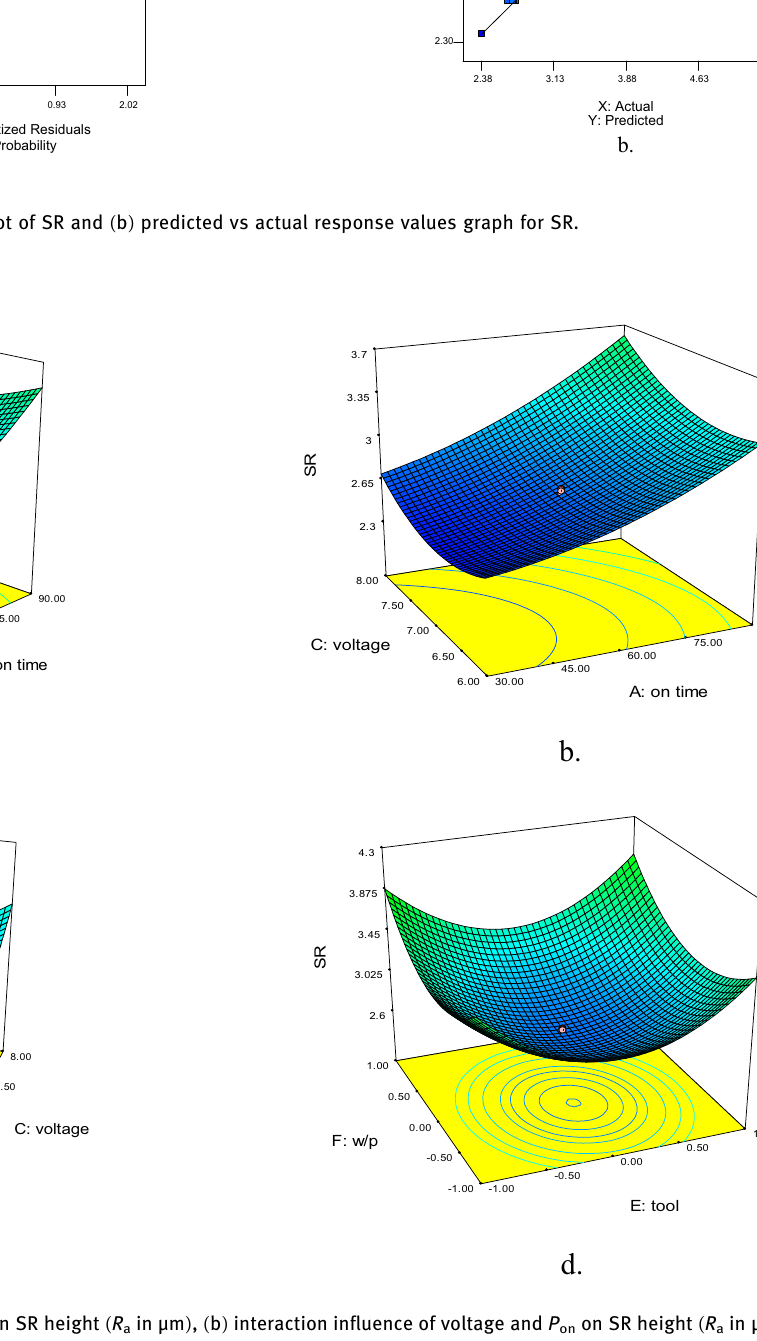
) , and ( d ) interaction e ff ect of workpiece and tool material on SR height a in µm